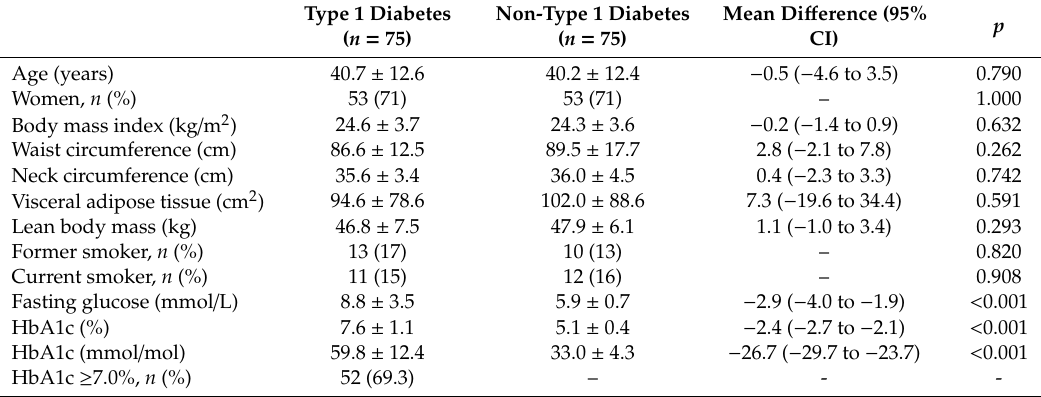
Table 1. Main clinical and metabolic characteristics of participants in the case-control study according to the presence of type 1